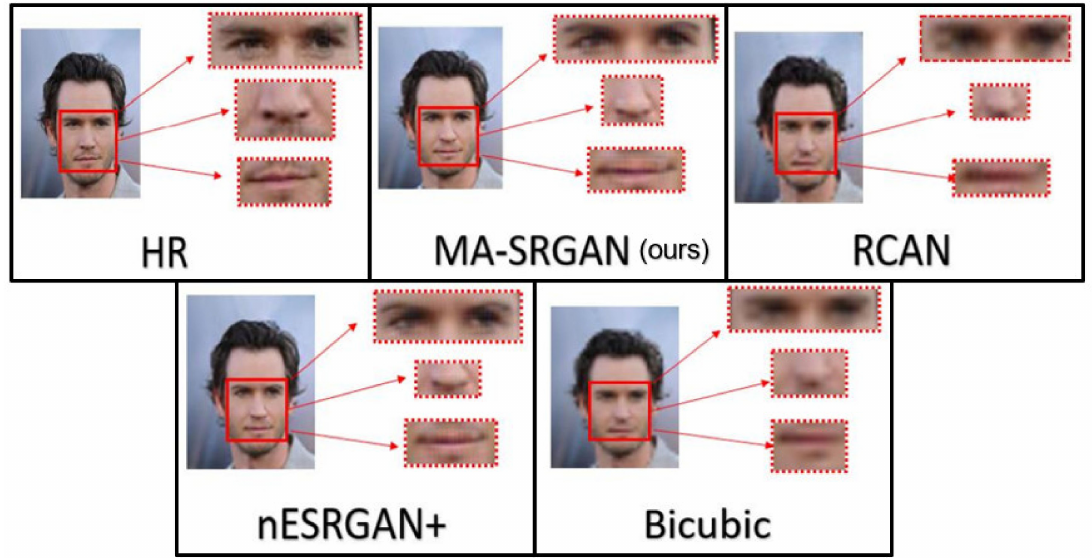
Figure 19. Visual results with Bicubic degradation ( × 4) on “011006” from the CelebA